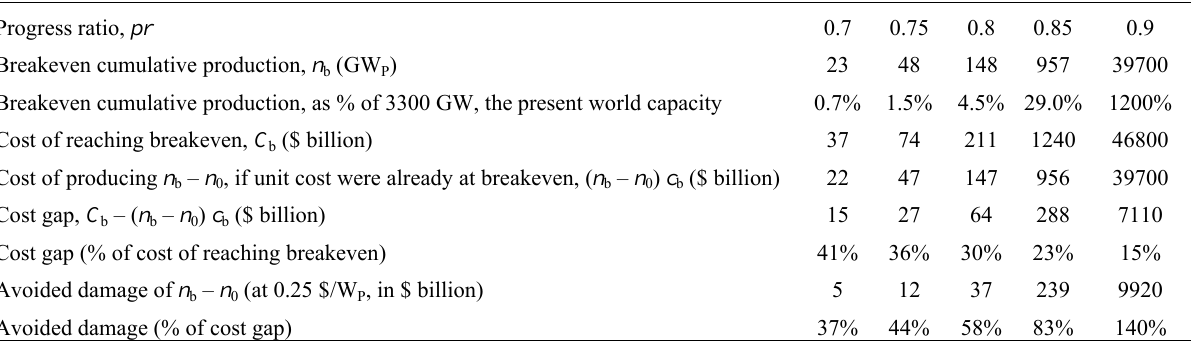
Table 7. Breakeven conditions for PV power under varying progress ratios (© 2004 Elsevier, reproduced with permission from [55]). 2 nd and 3 rd rows: cumulative production needed to achieve break-even; 4 th row: integral under the learning curve; 5 th row: cost of producing breakeven deployment under breakeven conditions; 6 th and 7 th rows: breakeven cost gap; 8 th and 9 th rows: avoided externality cost, to be compared with cost gap. Progress ratio, pr 0.7 0.75 0.8 0.85 0.9 Breakeven cumulative production, n b (GW P ) 23 48 148 957 39700 Breakeven cumulative production, as % of 3300 GW, the present world capacity 0.7% 1.5% 4.5% 29.0% 1200% Cost of reaching breakeven, C b ($ billion) 37 74 211 1240 46800 Cost of producing n b – n 0 , if unit cost were already at breakeven, ( n b – n 0 ) c b ($ billion) 22 47 147 956 39700 Cost gap, C b – ( n b – n 0 ) c b ($ billion) 15 27 64 288 7110 Cost gap (% of cost of reaching breakeven) 41% 36% 30% 23% 15% Avoided damage of n b – n 0 (at 0.25 $/W P , in $ billion) 5 12 37 239 9920 Avoided damage (% of cost gap) 37% 44% 58% 83%